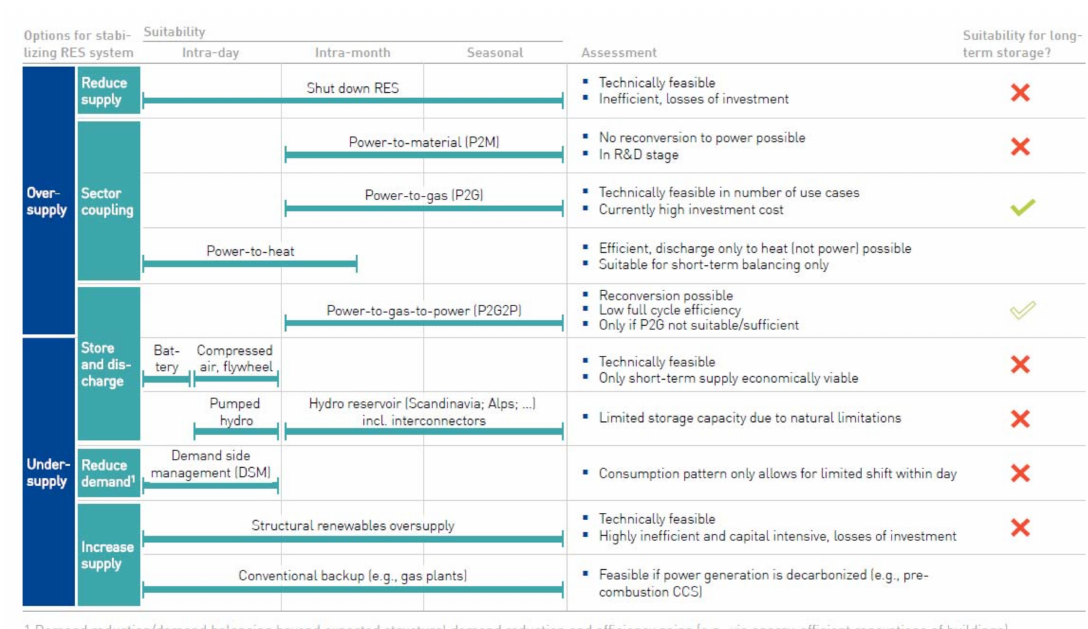
Figure 1. Comparison of sector coupling and storage technologies for grid balancing